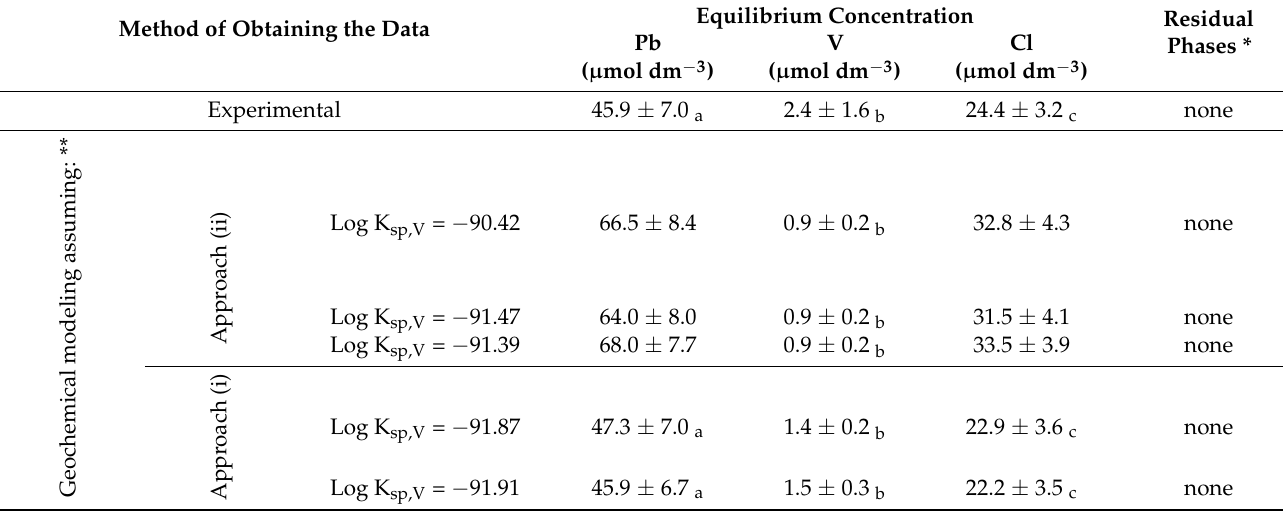
Table 2. Comparison of the selected solution parameters determined in dissolution experiments of vanadinite and via computing with geochemical model PHREEQC